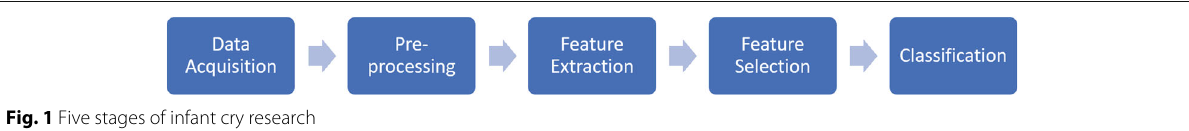
Fig. 1 Five stages of infant cry research